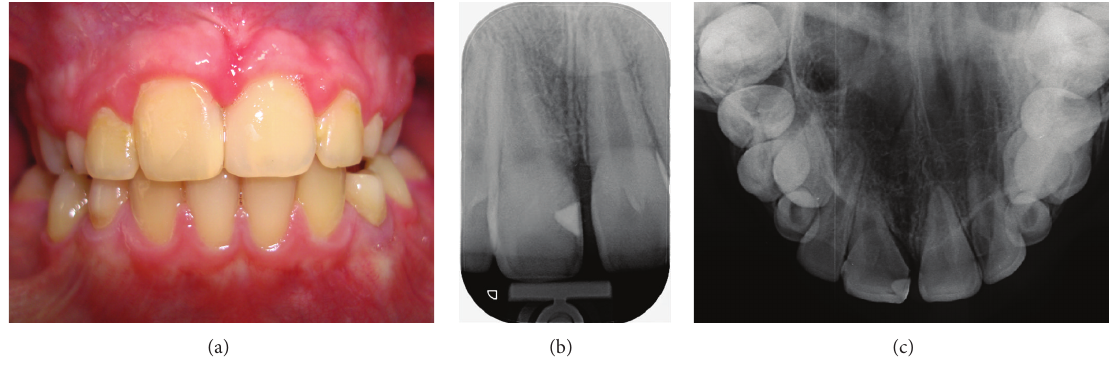
Figure 5: Clinical and radiographic appearance at 18-month